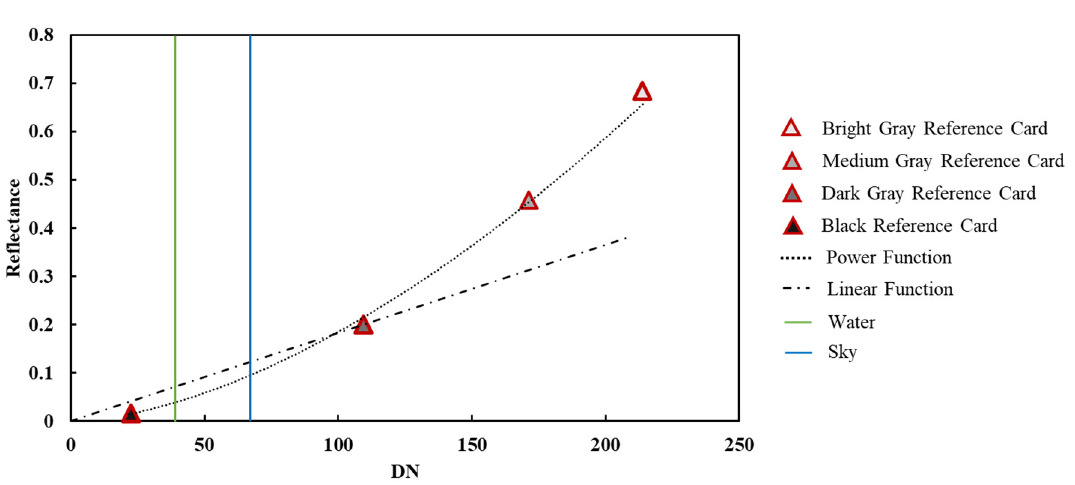
Figure 7. Comparison of the simulations of the relationship between digital pixel number (DN)